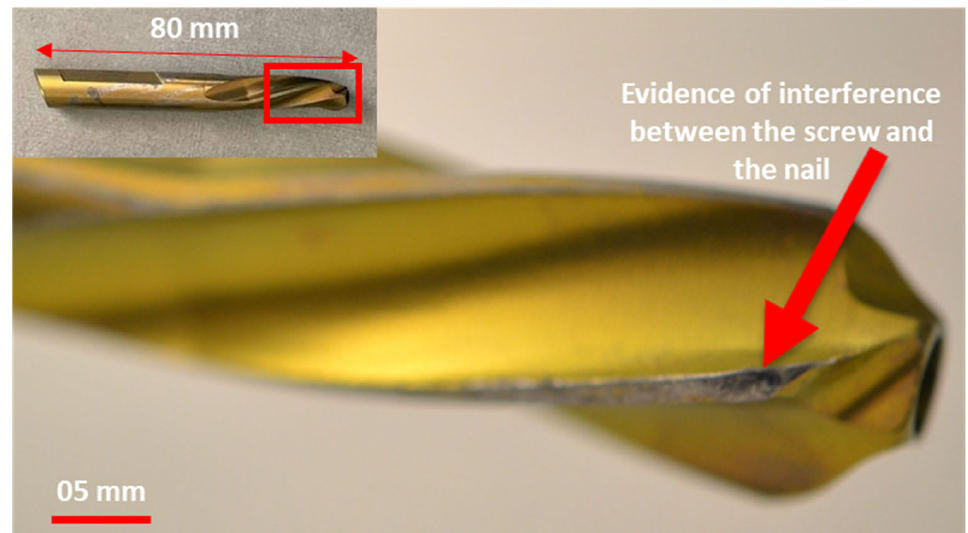
Figure 7. Evidence of scrape marks on the self ‐ tapping helical screw that suggests that may have been interference between the screw and the interior wall of the nail while being implanted within the body.